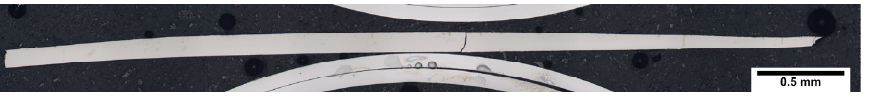
Figure 9. Cross-section of alloy B (Fe 81.2 Co 4 Si 0.5 B 9.5 P 4 Cu 0.8 ) after HPT deformation at room tempera- ture to N = 10.